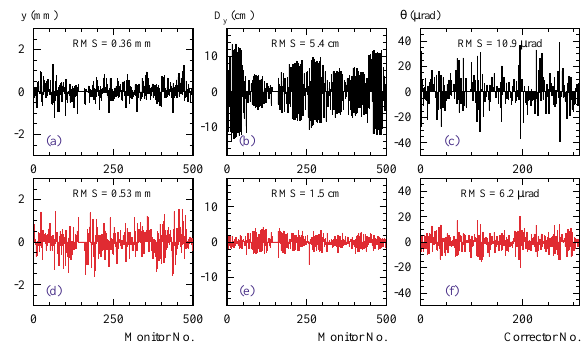
Monitor No. FIG. 7. (Color) The vertical orbit ( y ), dispersion ( D y ), and cor- rector kick strengths ( u ) after a traditional bare correction of the LEP orbit using MICADO (i.e., a (cid:1) 0 ) are shown on the three top figures (a), (b), and (c). The same quantities are shown after a correction with the DFS procedure on the bottom figures (d), (e), and (f). This experiment was performed with a single beam.